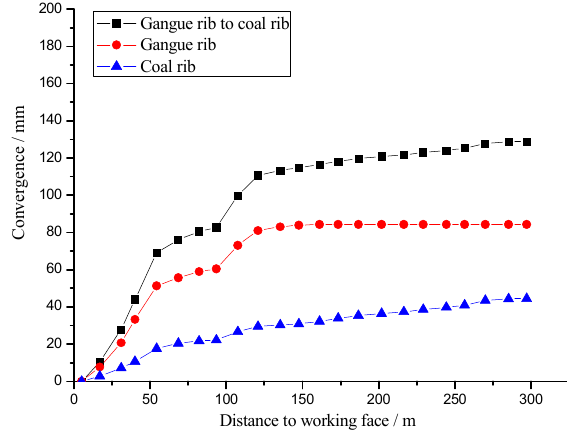
Energies 2018 , 11 , x FOR PEER REVIEW Figure 19. Horizontal convergence of GERRC. Figure 19. Horizontal convergence of GERRC.